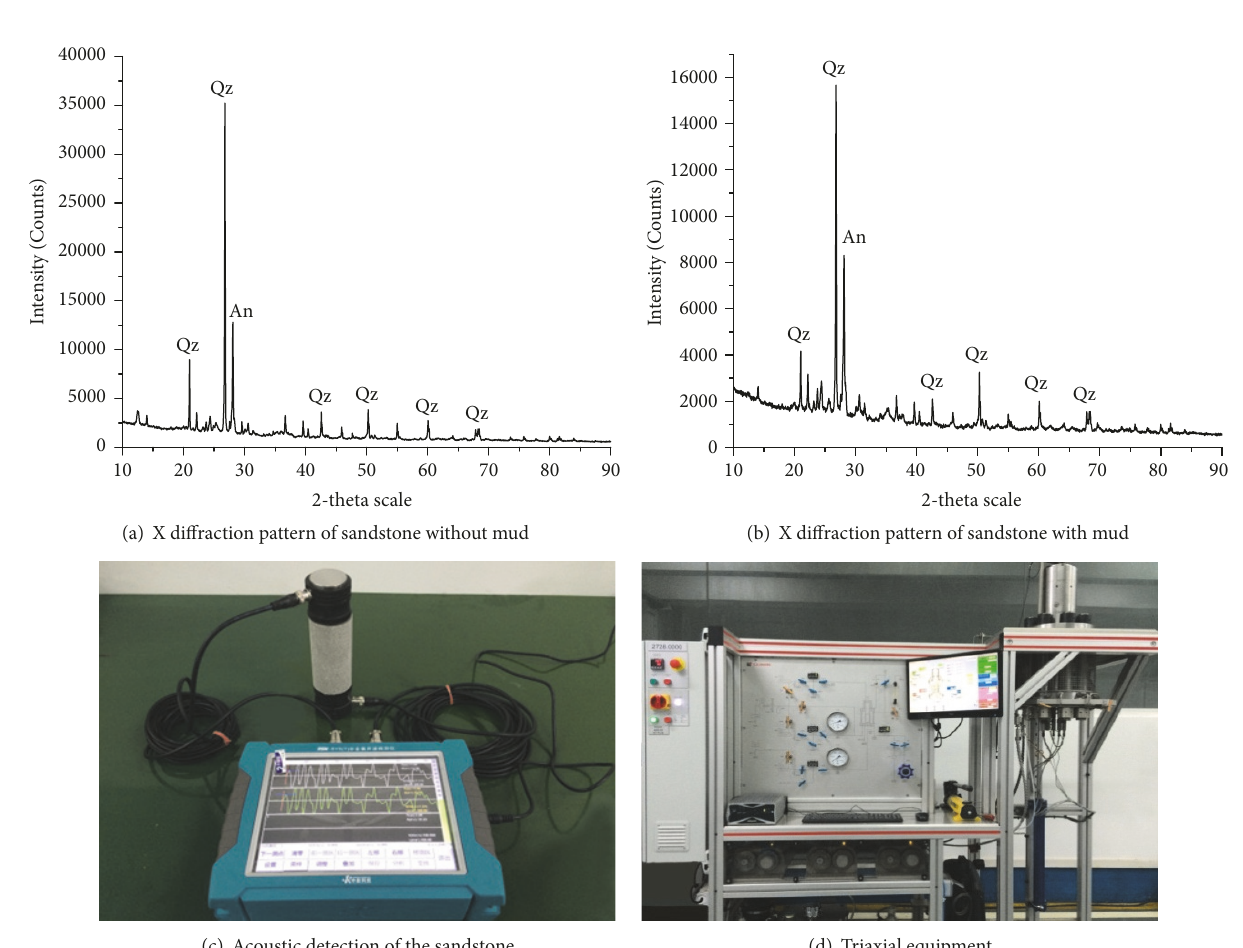
Figure 2: Acoustic detection tests and triaxial